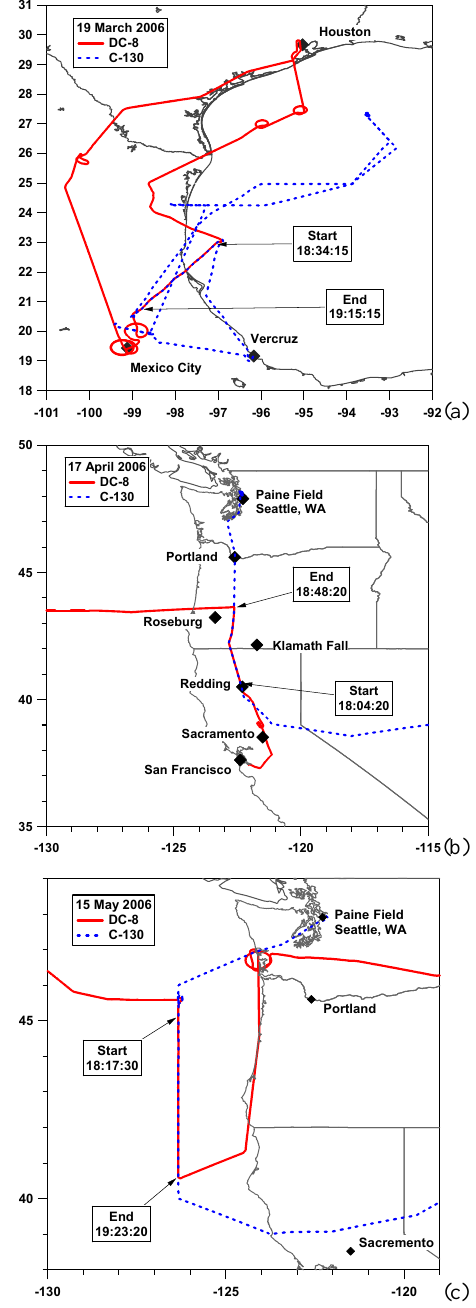
Fig. 1. (a) NASA DC-8 and NSF C-130 flights on 19 March 2006. The intercomparison period is indicated by the start and end times. The DC-8 flight path is shown as a solid red line. The C-130 flight path is shown as a blue dotted line. (b) NASA DC-8 and NSF C-130 flights on 17 April 2006. The intercomparison period is indicated by the start and end times. The DC-8 flight path is shown as a solid red line. The C-130 flight path is shown as a blue dotted line. (c) NASA DC-8 and NSF C-130 flights on 15 May 2006. The in- tercomparison period is indicated by the start and end times. The DC-8 flight path is shown as a solid red line. The C-130 flight path is shown as a blue dotted